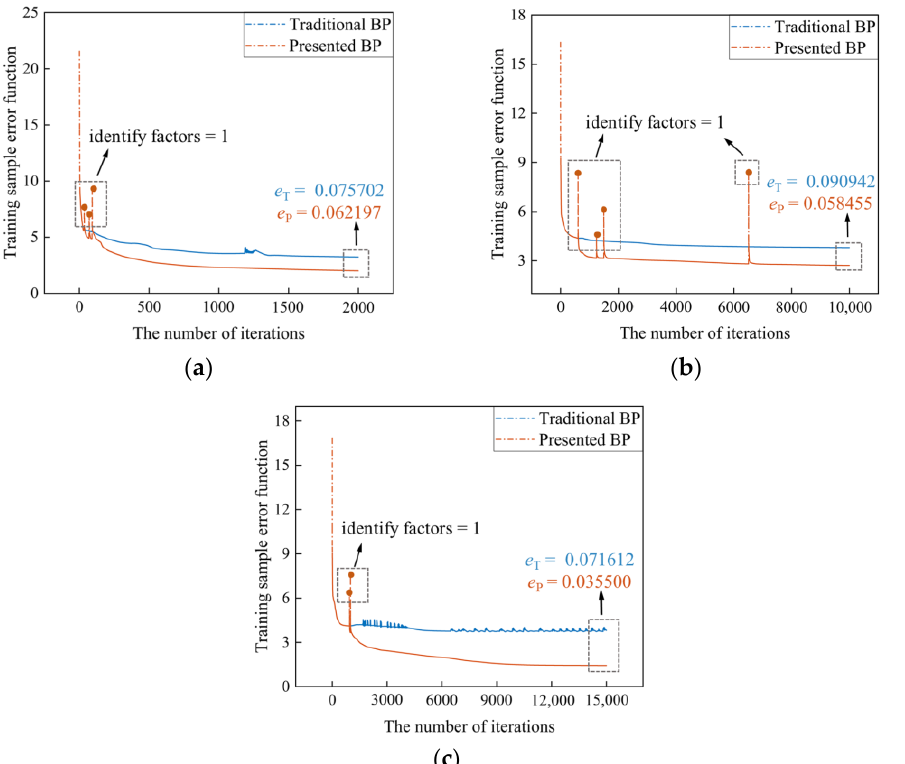
Figure 8. The error function of the traditional model and the presented model during training: ( a ) the number of iteration steps K of the models is 2000; ( b ) the number of iteration steps K of the models is 10,000; ( c ) the number of iteration steps K of the models is 15,000.